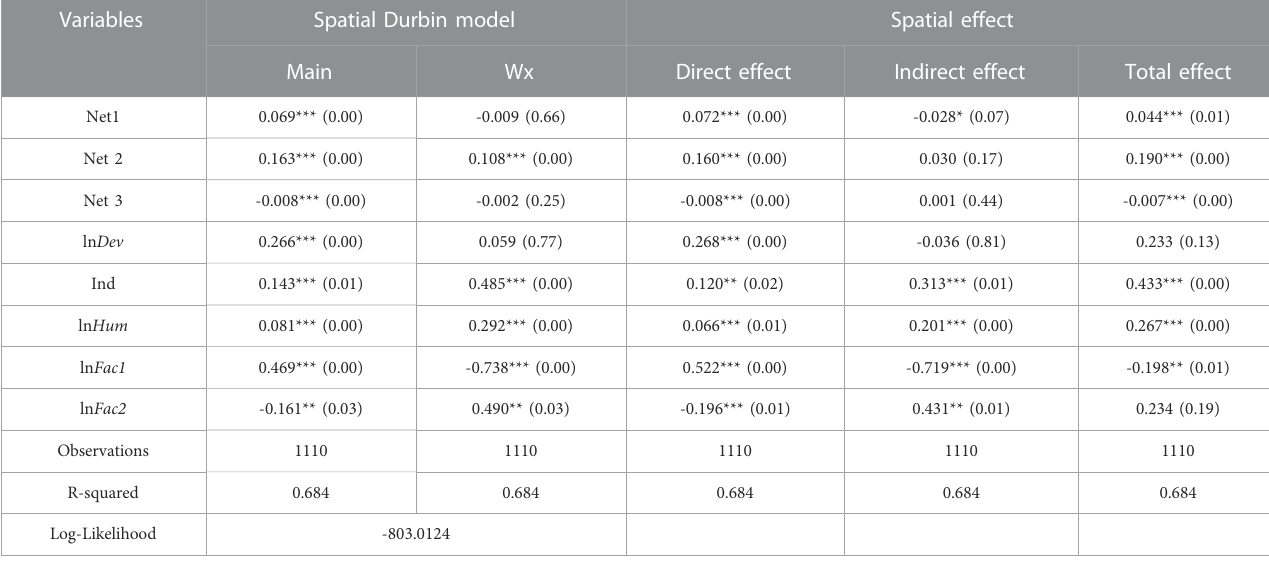
TABLE 7 Estimation results of the replaced spatial weight